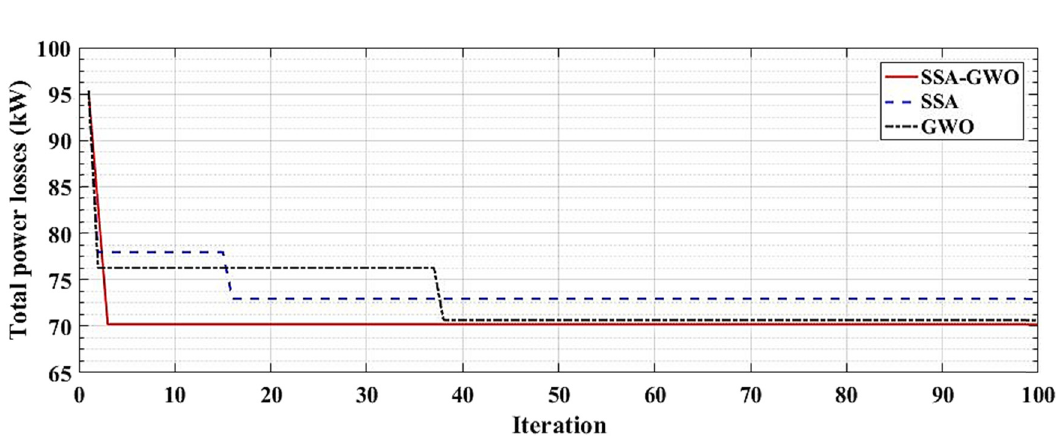
Figure 9: The convergence with SSA, GWO, and SSA – GWO and fi ve DGs on the IEEE 123 - bus simulation